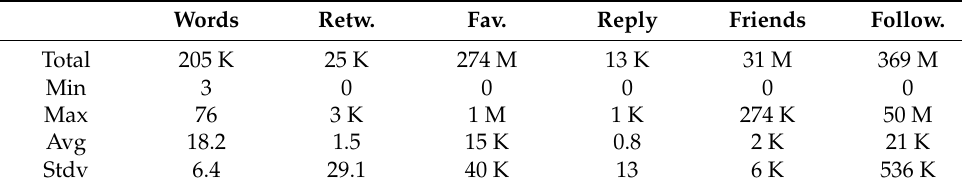
Table 2. Summary statistics.